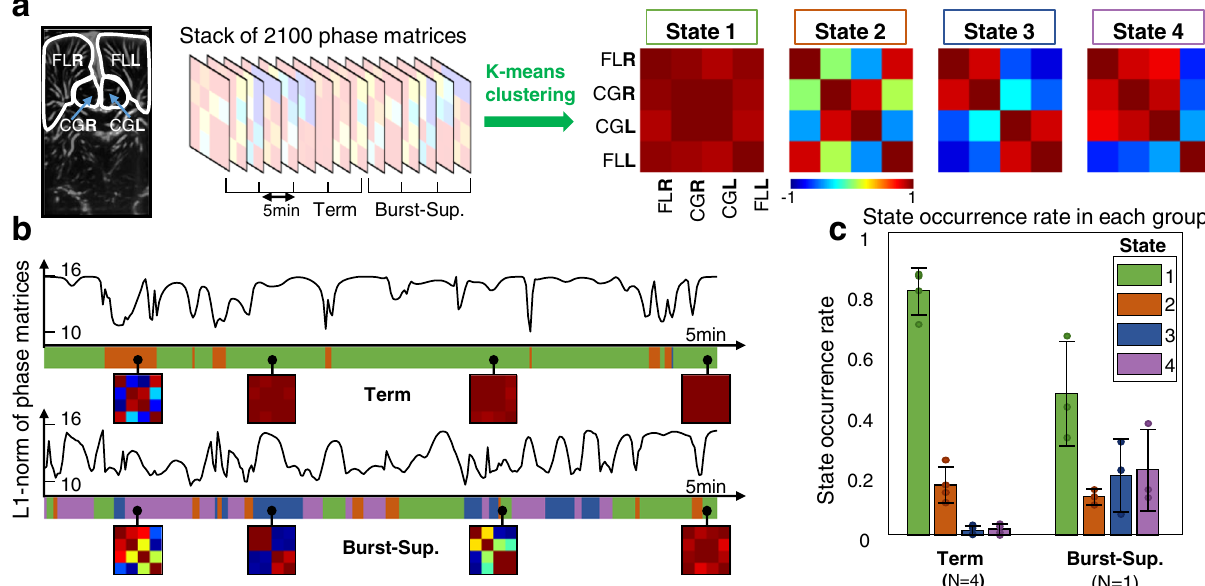
Fig. 5 Dynamic connectivity reveals abnormal pattern in a newborn with burst suppression. ( FL frontal lobe, CG cingulate gyrus, T thalamus, R/L right/ left) a Four cerebral areas are included in the analysis: the frontal lobes and cingulate gyri in left and right hemispheres. The phase matrix stack is the result of four independent 5-min-long acquisitions on four term neonates, and three acquisitions from the neonate with burst-suppression EEG pattern (Burst- Sup.). Four connectivity states are derived from the k-means algorithm on the phase matrix stack (see Fig. 4 for details). b Typical L 1 norm time course for acquisitions of one term infant and the neonate with burst suppression. The closest state to the current phase matrix is encoded in the color ribbon below each curve. Four examples of phase matrices are shown in small square boxes for each patient. The colors in the ribbon representing the different states are de fi ned in c legend box. c Occurrence rate of each state averaged on each population (no statistical test because only one patient with Burst-Sup.). Error bars represent the standard deviation of either each patient assessment for term patients or each acquisition for the patient with Burst-Sup. Center of error bar is the mean value. N = number of independent patients in each group, with one acquisition per patient in the term group, and three acquisition per patient for the Burst-Sup group. Source data are provided as a Source Data fi